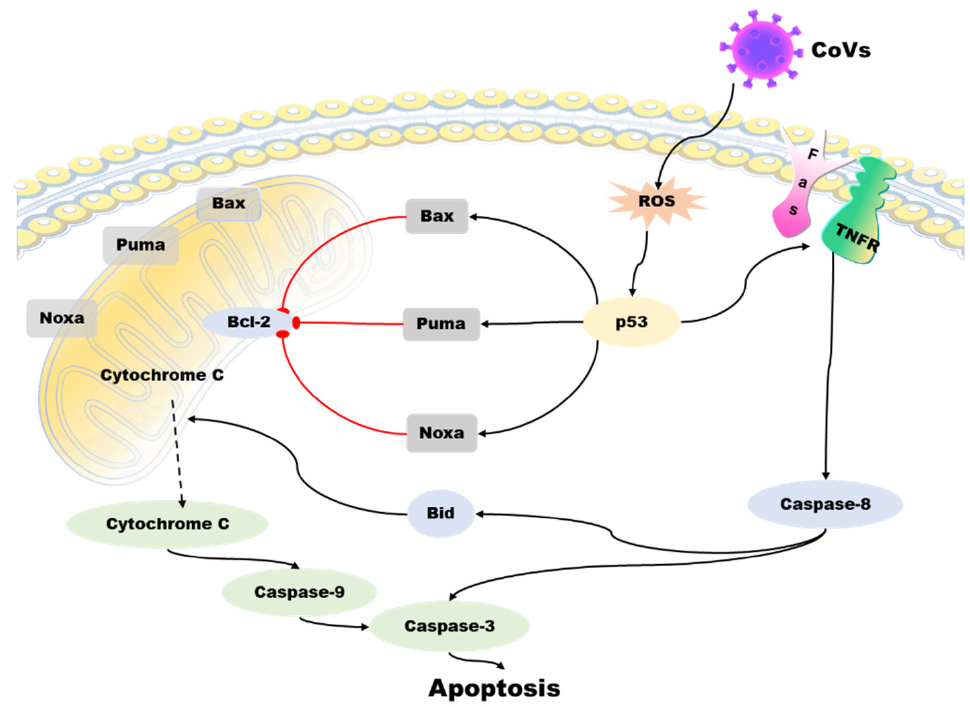
Figure 4. Role of p53 in the regulation of apoptosis during coronavirus infection. The virus induces ROS accumulation in cells and activates p53 protein, which activates the pro-apoptotic proteins of the Bcl-2 family -Bax, Noxa, PUMA, and BID, antagonizing the anti-apoptotic effect of BCL-2. Then, cytochrome C from mitochondria spills over, triggering a cascade of caspase proteins, leading to apoptosis. p53 can also act on the tumor necrosis factor receptor (TNFR) family to activate caspase-3 and caspase-8 through the exogenous apoptotic pathway and cause apoptosis. In many traditional views, virus-induced apoptosis is regarded as an antiviral strategy for the host. The relationship between apoptosis and viruses is very subtle and complex. For some viruses, inhibiting host cell apoptosis can increase the replication time in the cell, and rapid cell death may reduce the replication level. The human cytomegalovirus (HCMV)–encoded UL37 exon-1 protein (UL37 × 1) can increase HCMV replication and and anti-apoptotic activity of UL37 × 1 is essential for HCMV replication in vivo [65]. Flaviviruses, such as the Zika virus (ZIKV), produce subgenomic flavivirus RNA (sfRNA) using host mRNA degradation mechanisms. sfRNA can modulate the expression of genes cell apoptosis in mosquito tissue. This process can prolong viral genome replication and promote virion assembly, which, in turn, facilitates viral infection [66]. Hepatitis C virus (HCV) NS5A proteins form complexes with inositol triphosphate receptor type 3 (IP3R3) and F-box and leucine 2 (FBXL2), promoting the FBXL2-mediated